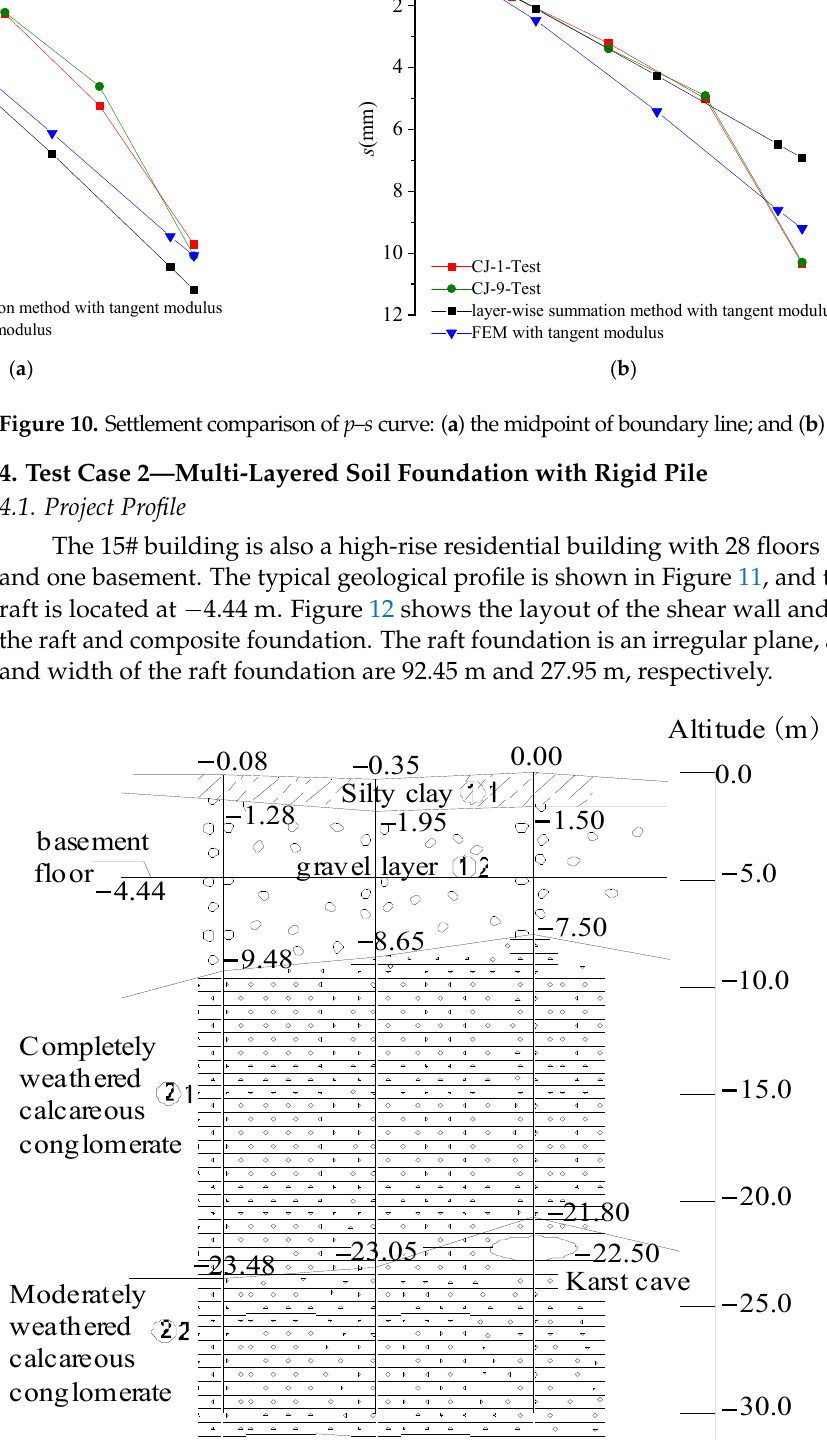
Figure 11. Typical geological profile of 15# building.